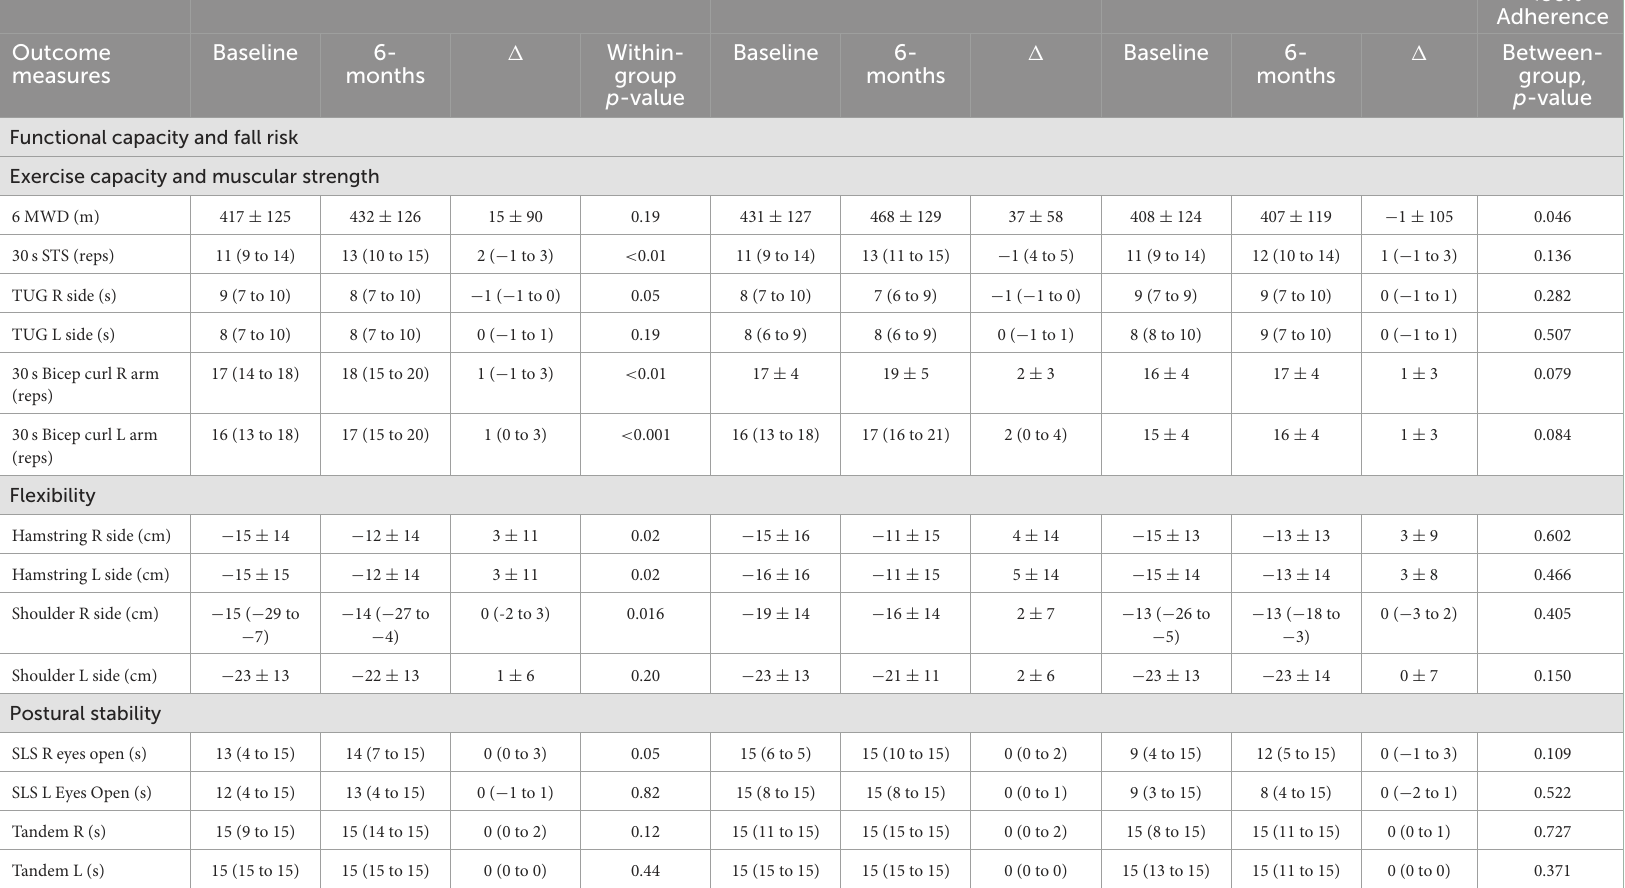
TABLE 2 Summary of 6-month